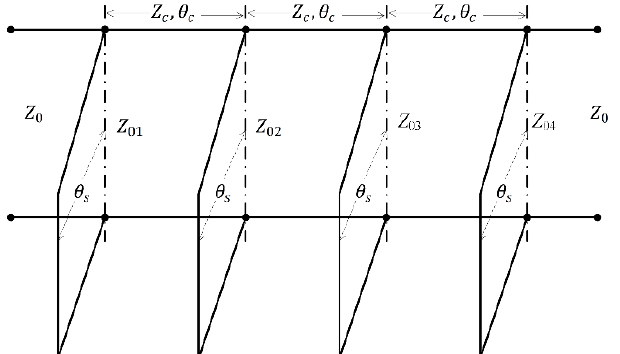
Figure 4. Conventional UWB bandpass filter structure with uniform short-circuited stubs of length θ s and uniform impedance Z 01 and Z 02 .